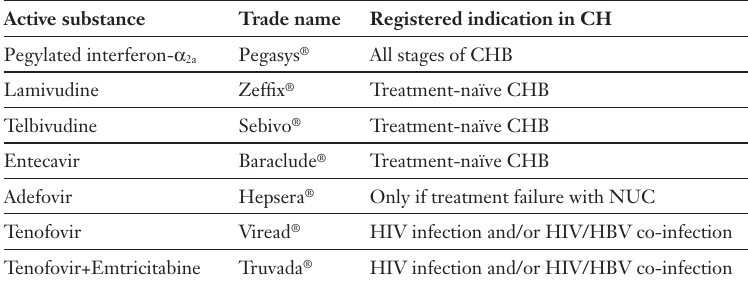
Available drugs to treat CHB in Switzerland as of June 2009. Active